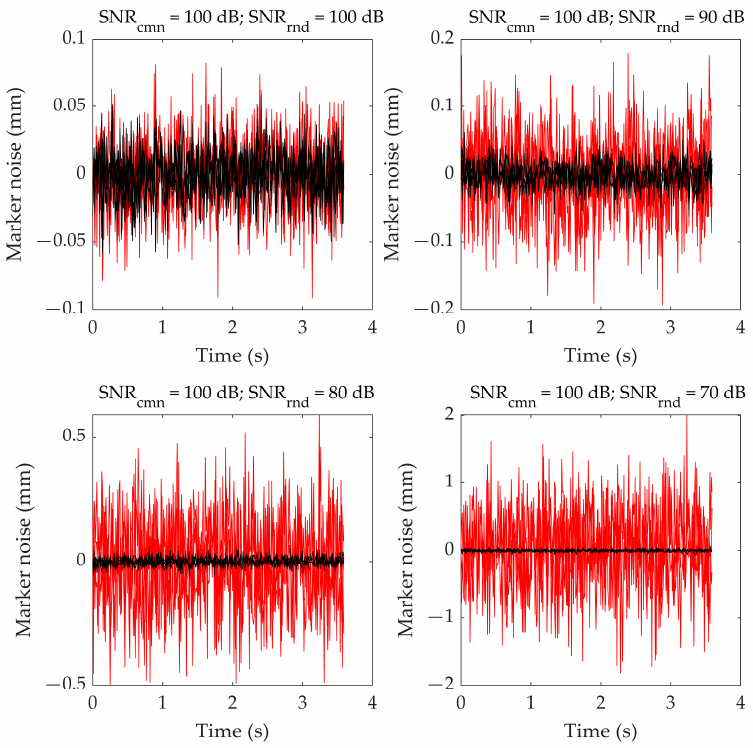
Figure 2. Random (red) and common (black) noise signals for different signal-to-noise ratios.